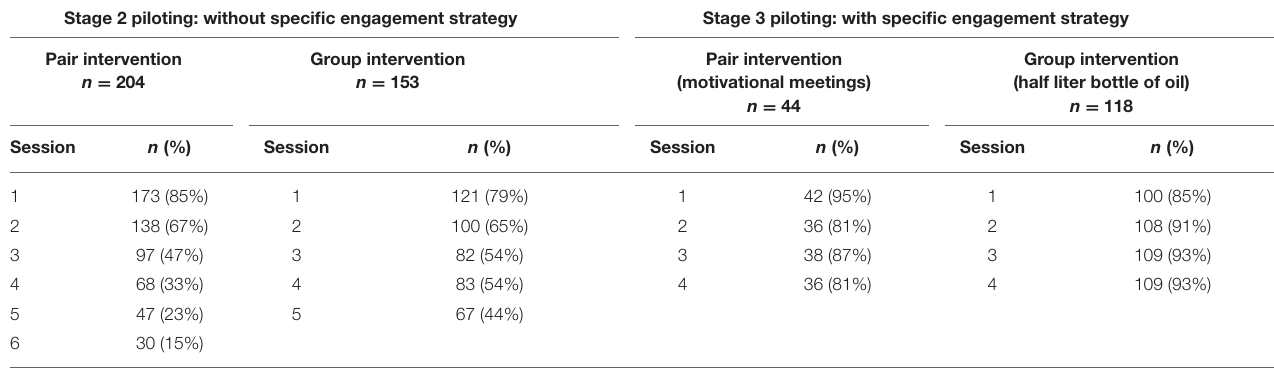
TABLE 2 | Mothers’ attendance at parenting sessions in stage 2 and stage 3. Stage 2 piloting: without specific engagement strategy Stage 3 piloting: with specific engagement